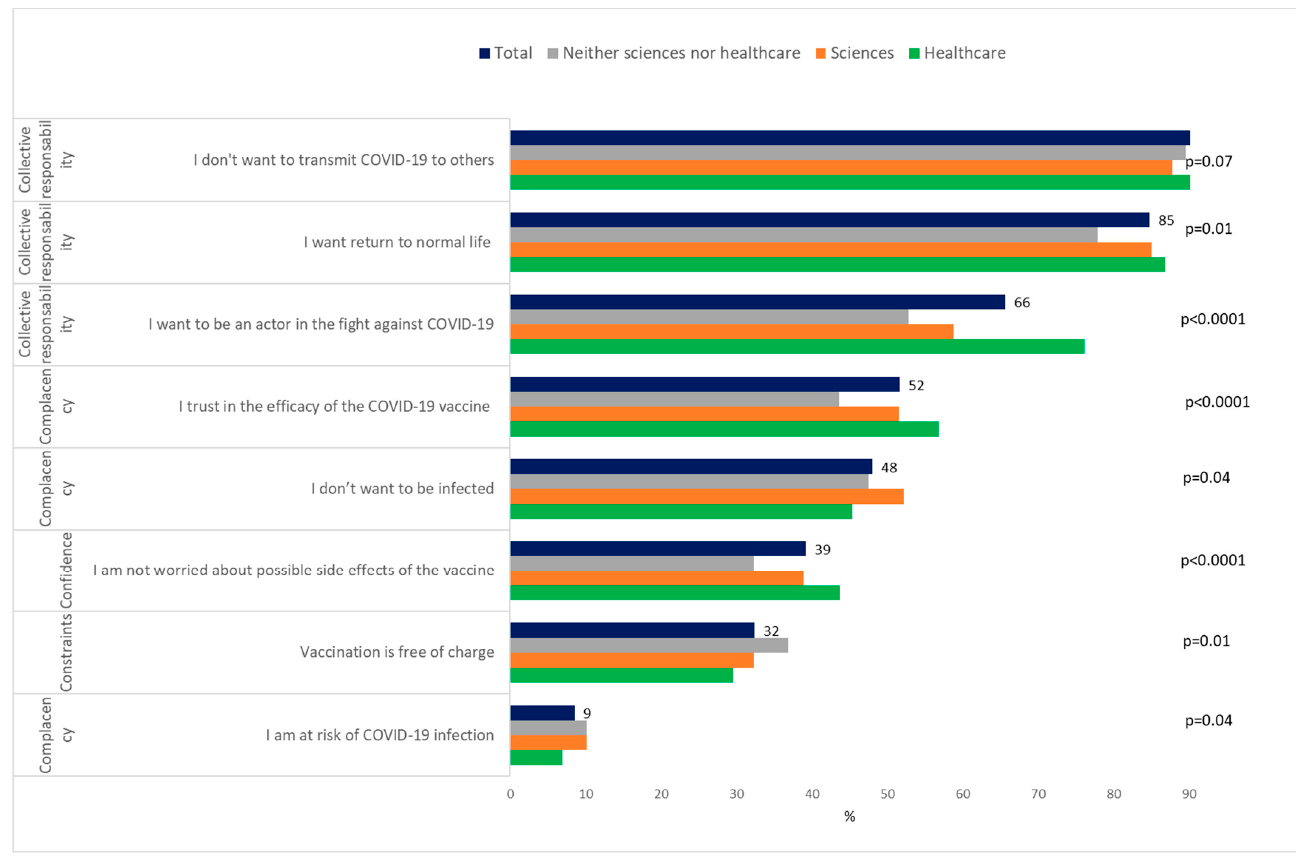
Figure 3. University students’ motivations of COVID-19 vaccine acceptance ( N = 1790).